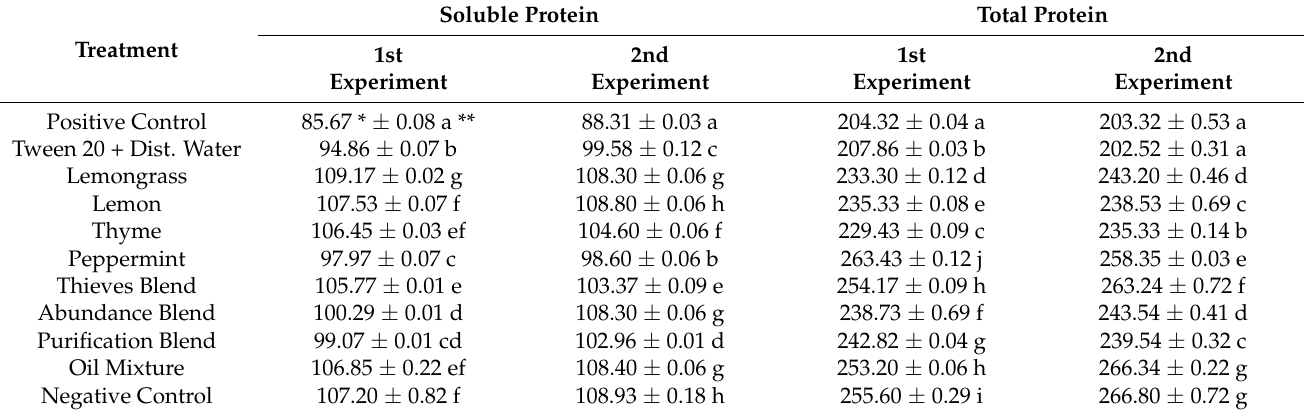
Table 6. Effect of treatment with essential oils (2.5 mL/L) on the protein content (mg/g dray weight) in the cucumber plants under greenhouse conditions.